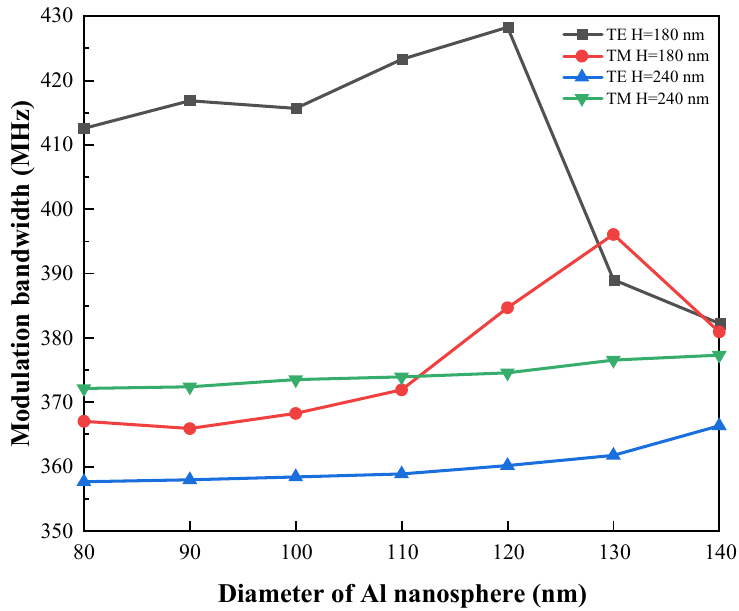
Figure 8. TE and TM polarized modulation bandwidth of Al nanosphere structure DUV-LEDs with various nanopillar heights as a function of diameter of Al nanosphere.